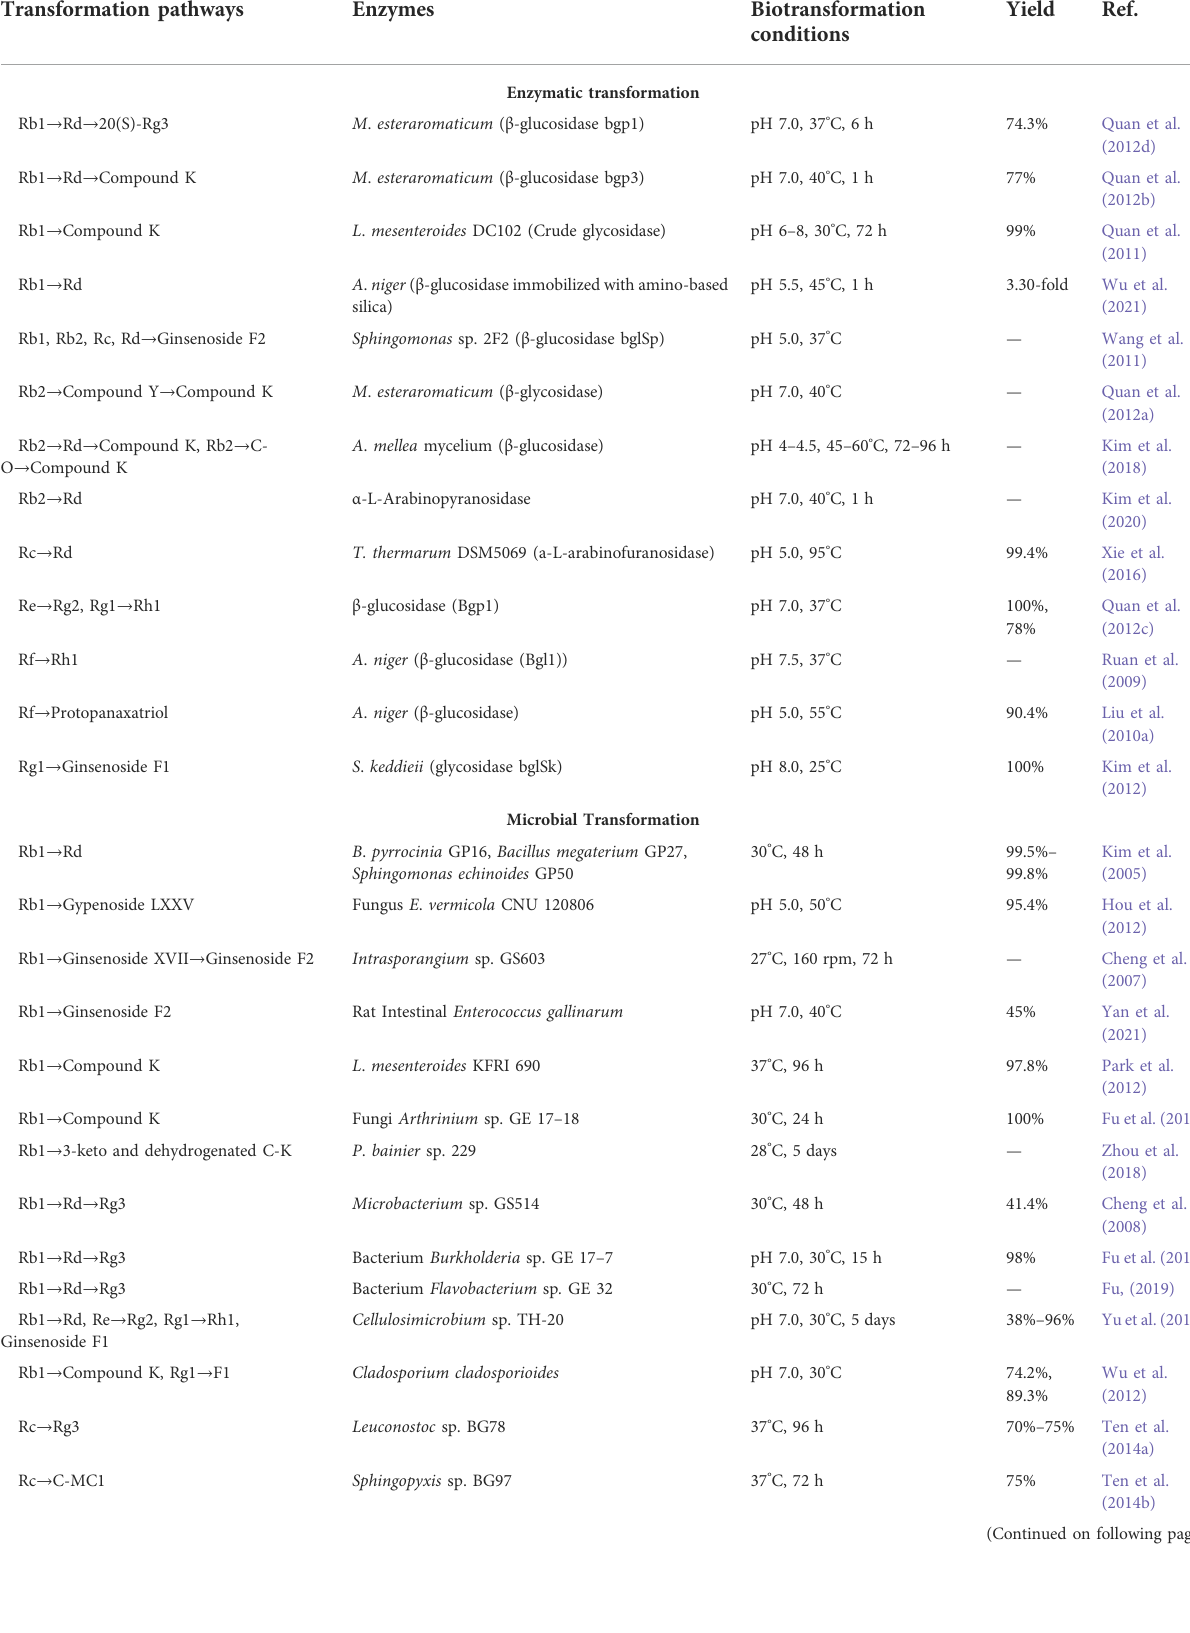
TABLE 2 Biotransformation of major ginsenosides into rare ginsenosides. Transformation